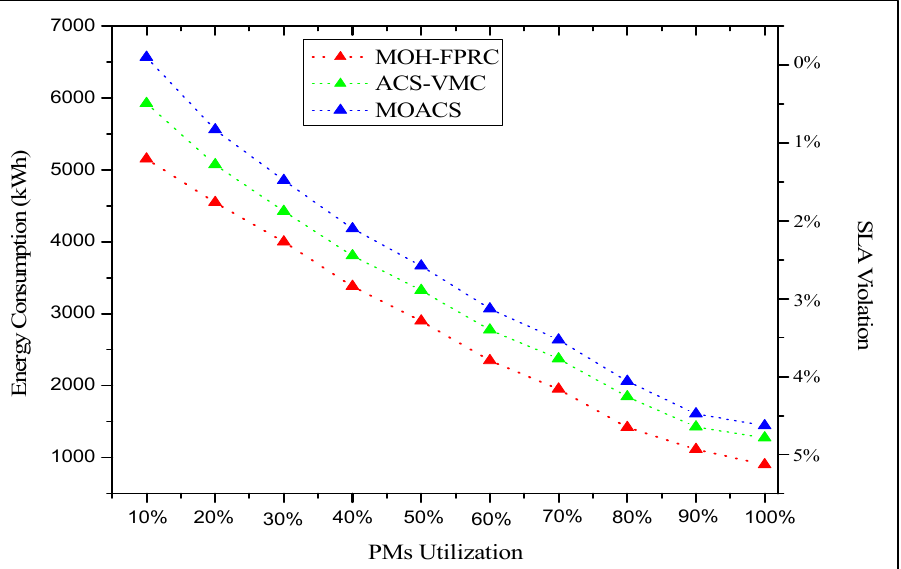
Figure 6. Performance comparison of PM Energy consumption, SLA violation and utilization. Table 4. MOH-FPRC performance improvement on energy consumption and SLA violation.